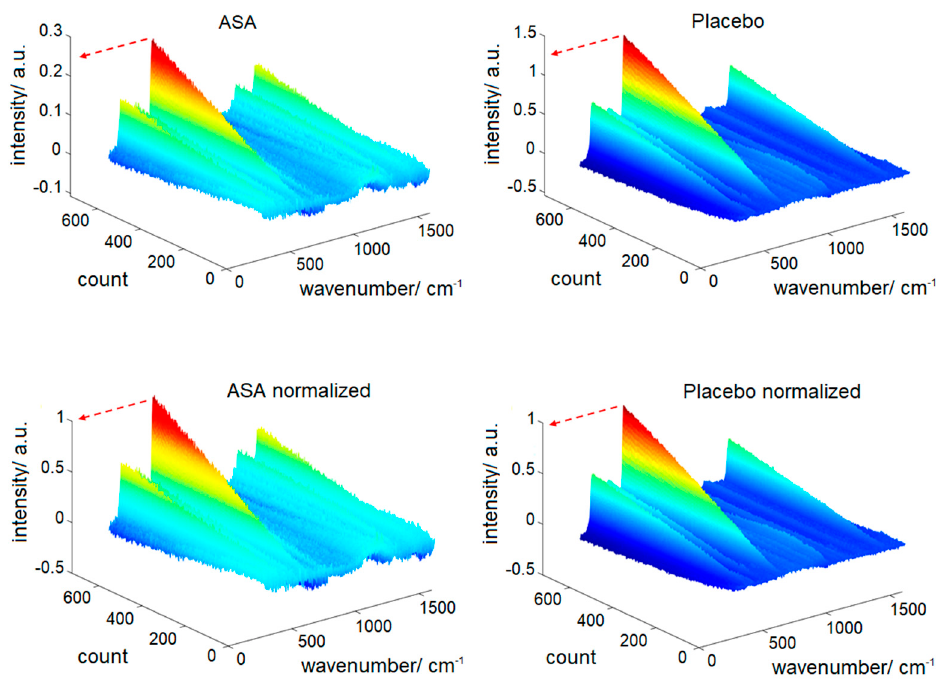
Figure 1. Standard normal variate (SNV)-preprocessed differential spectra; ( top ) before and ( bottom ) after normalization.